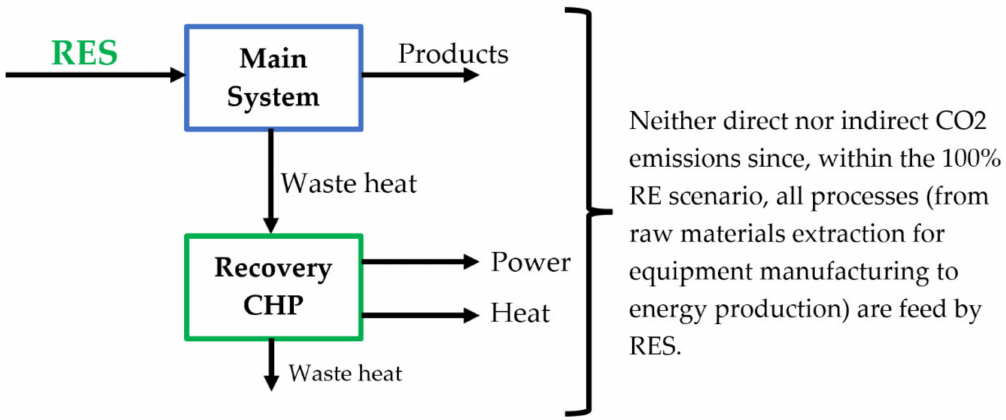
Figure 11. Schematic diagram of CO 2 emissions for a generic cogeneration system fed by RES as its primary energy source (future 100% RE